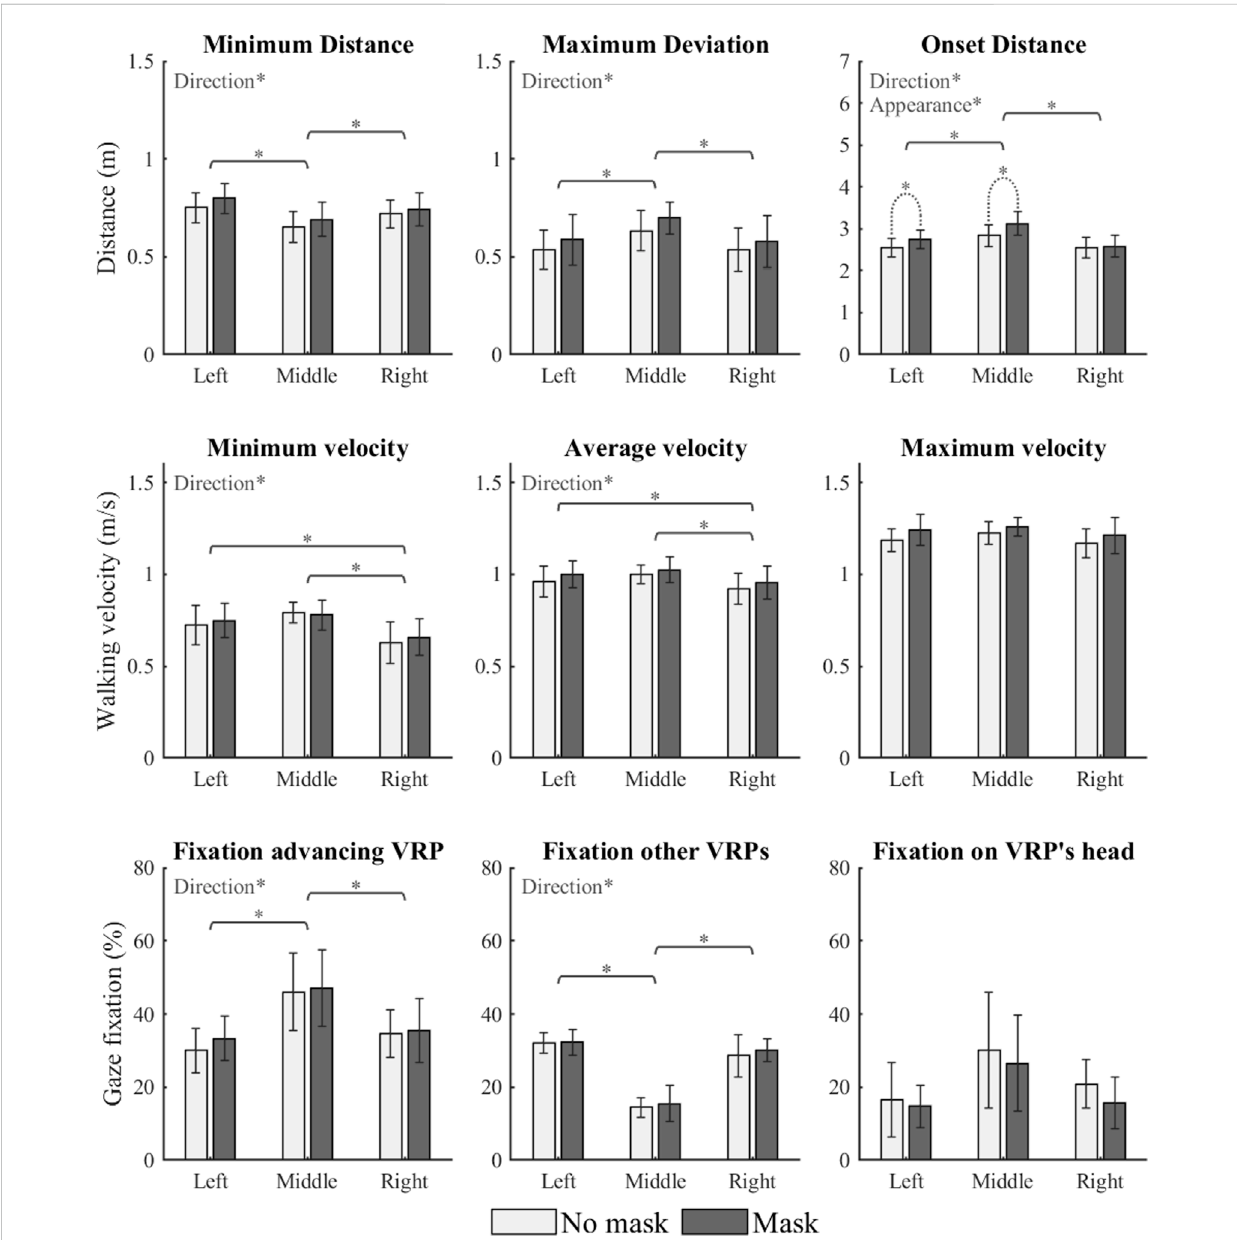
FIGURE 4 Outcomes describing participants ’ behaviour. Bar graph representing the mean±1SE for all outcome measures. Light grey bars represent the unmasked condition and dark gray bars represent the masked condition. The X-axis represents the direction of VRP approach.